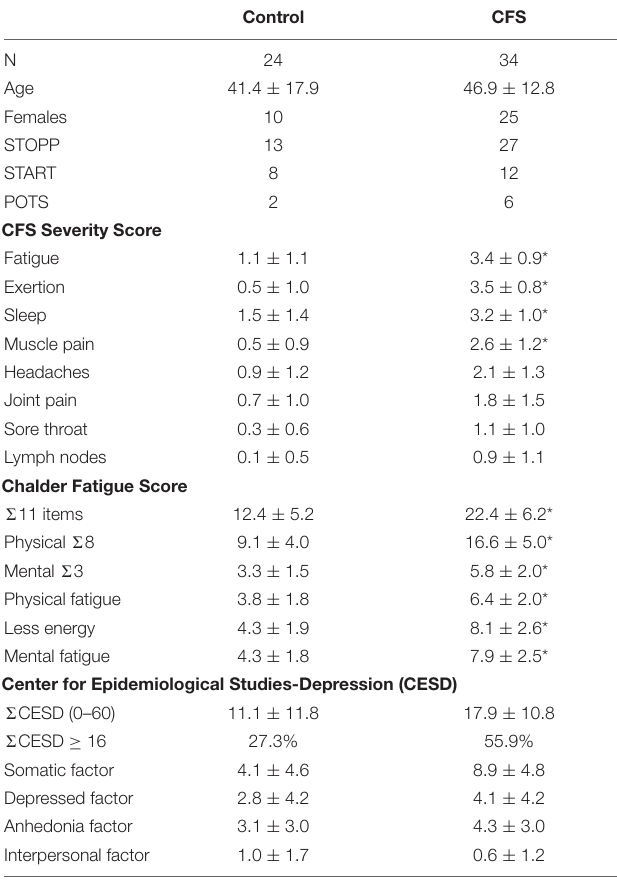
TABLE 1 | Demographic and questionnaire results.